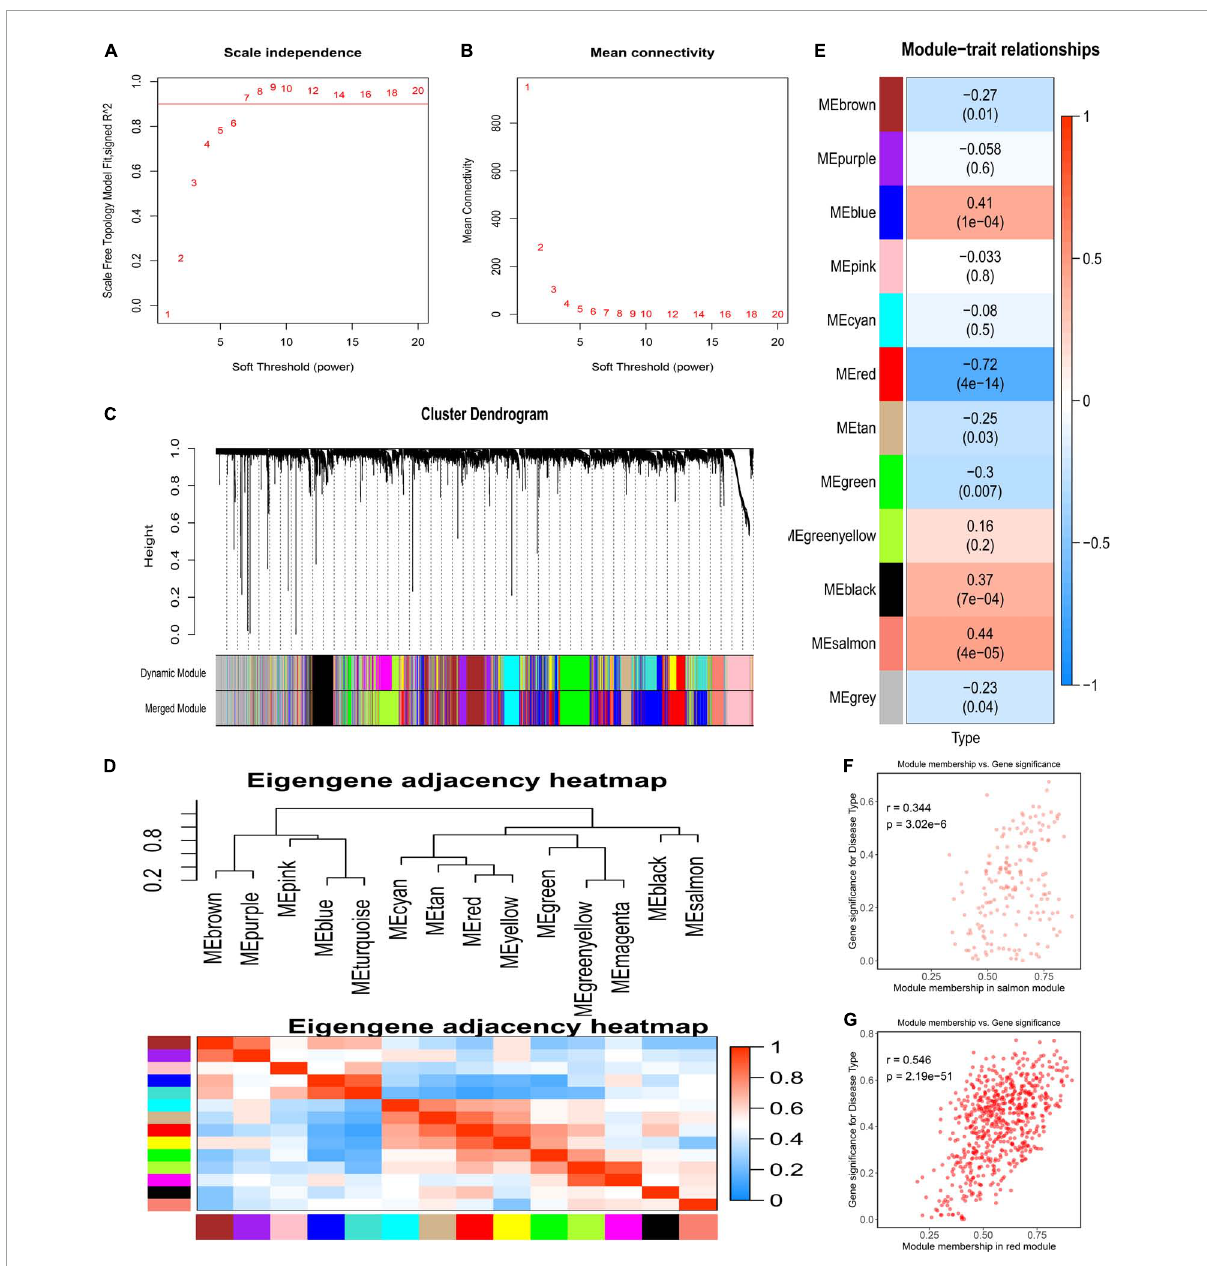
FIGURE2 Detection of weighted gene co-expression network and modules. (A) Scale-free topological indices at various soft-thresholding powers. (B) The correlation analysis between the soft-thresholding powers and mean connectivity of the network. (C) Gene clustering diagram based on hierarchical clustering under optimal soft-thresholding power. (D) The heatmap of the eigengene adjacency. (E) Correlations between gene modules and PAH. (F) The correlation between the salmon module memberships and the gene significance. (G) The correlation between the red module memberships and the gene